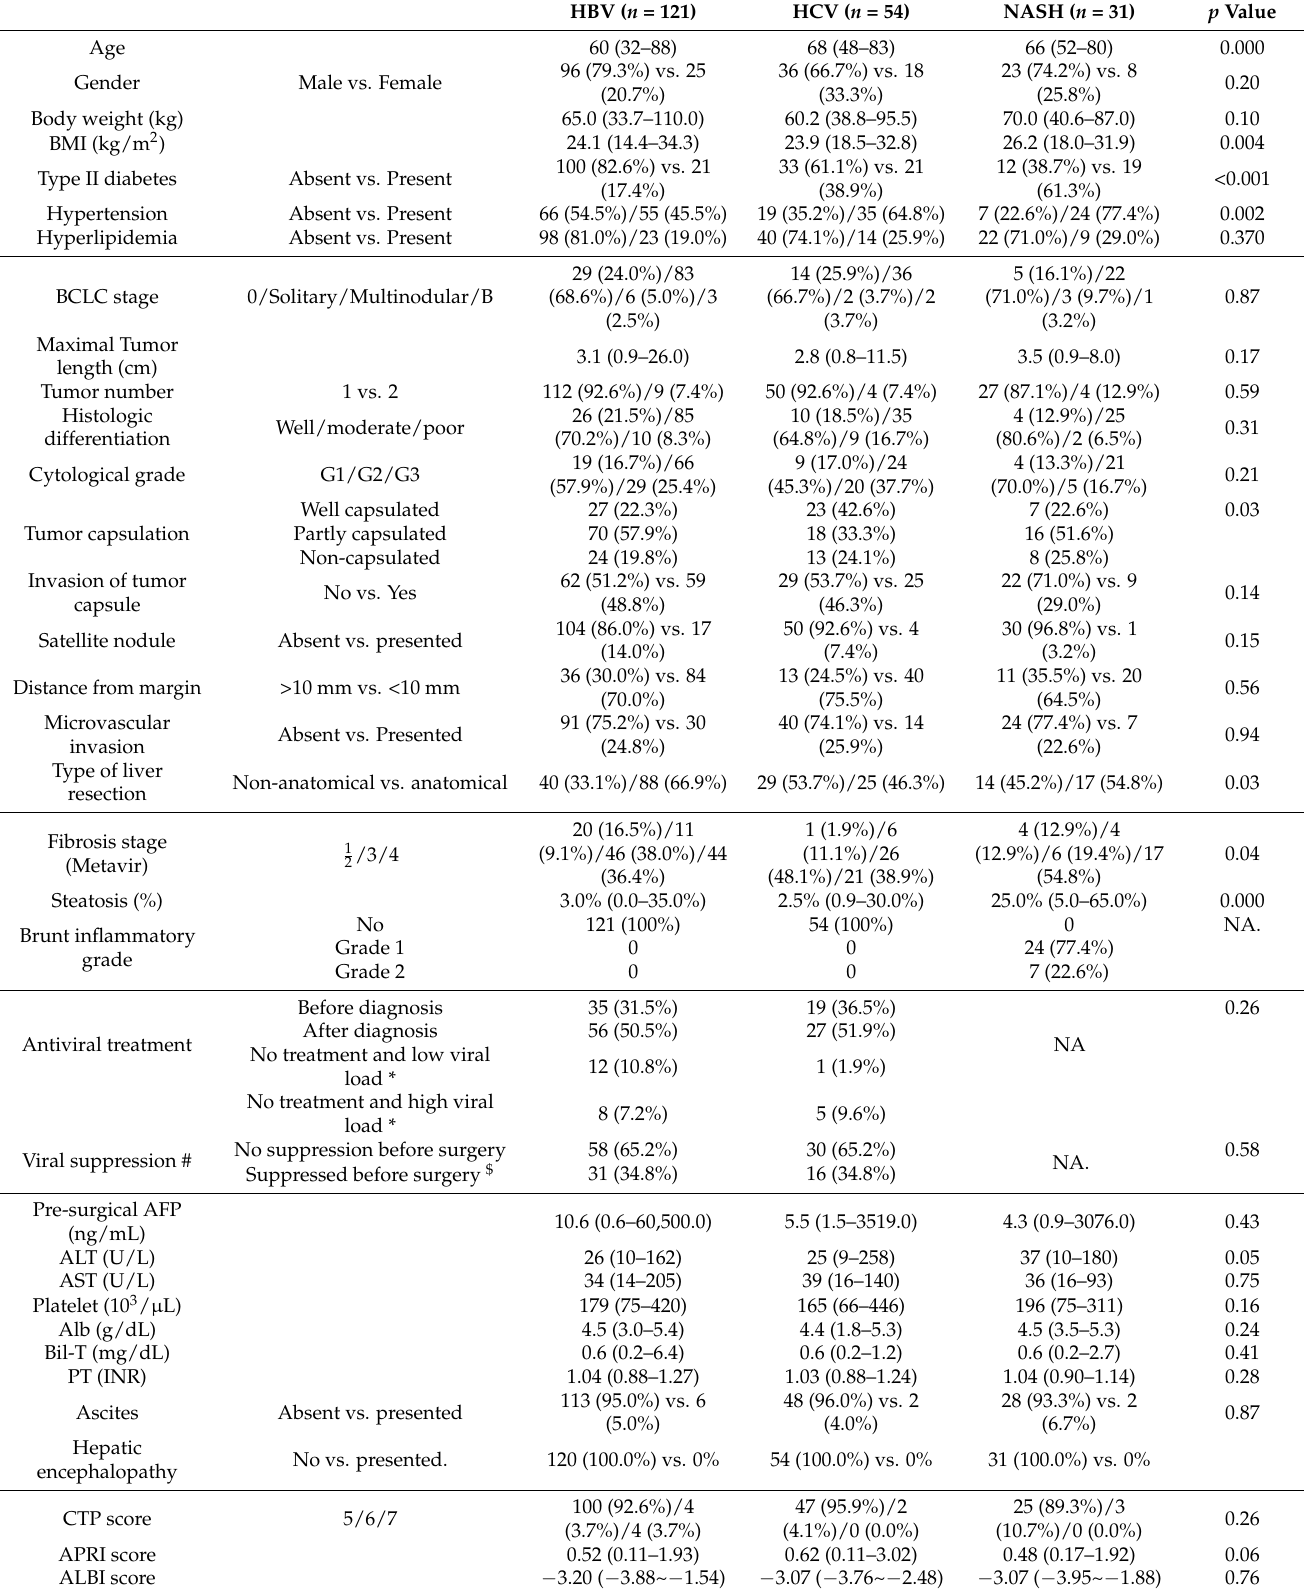
Table 1. Baseline characteristics of patients according to etiology of liver